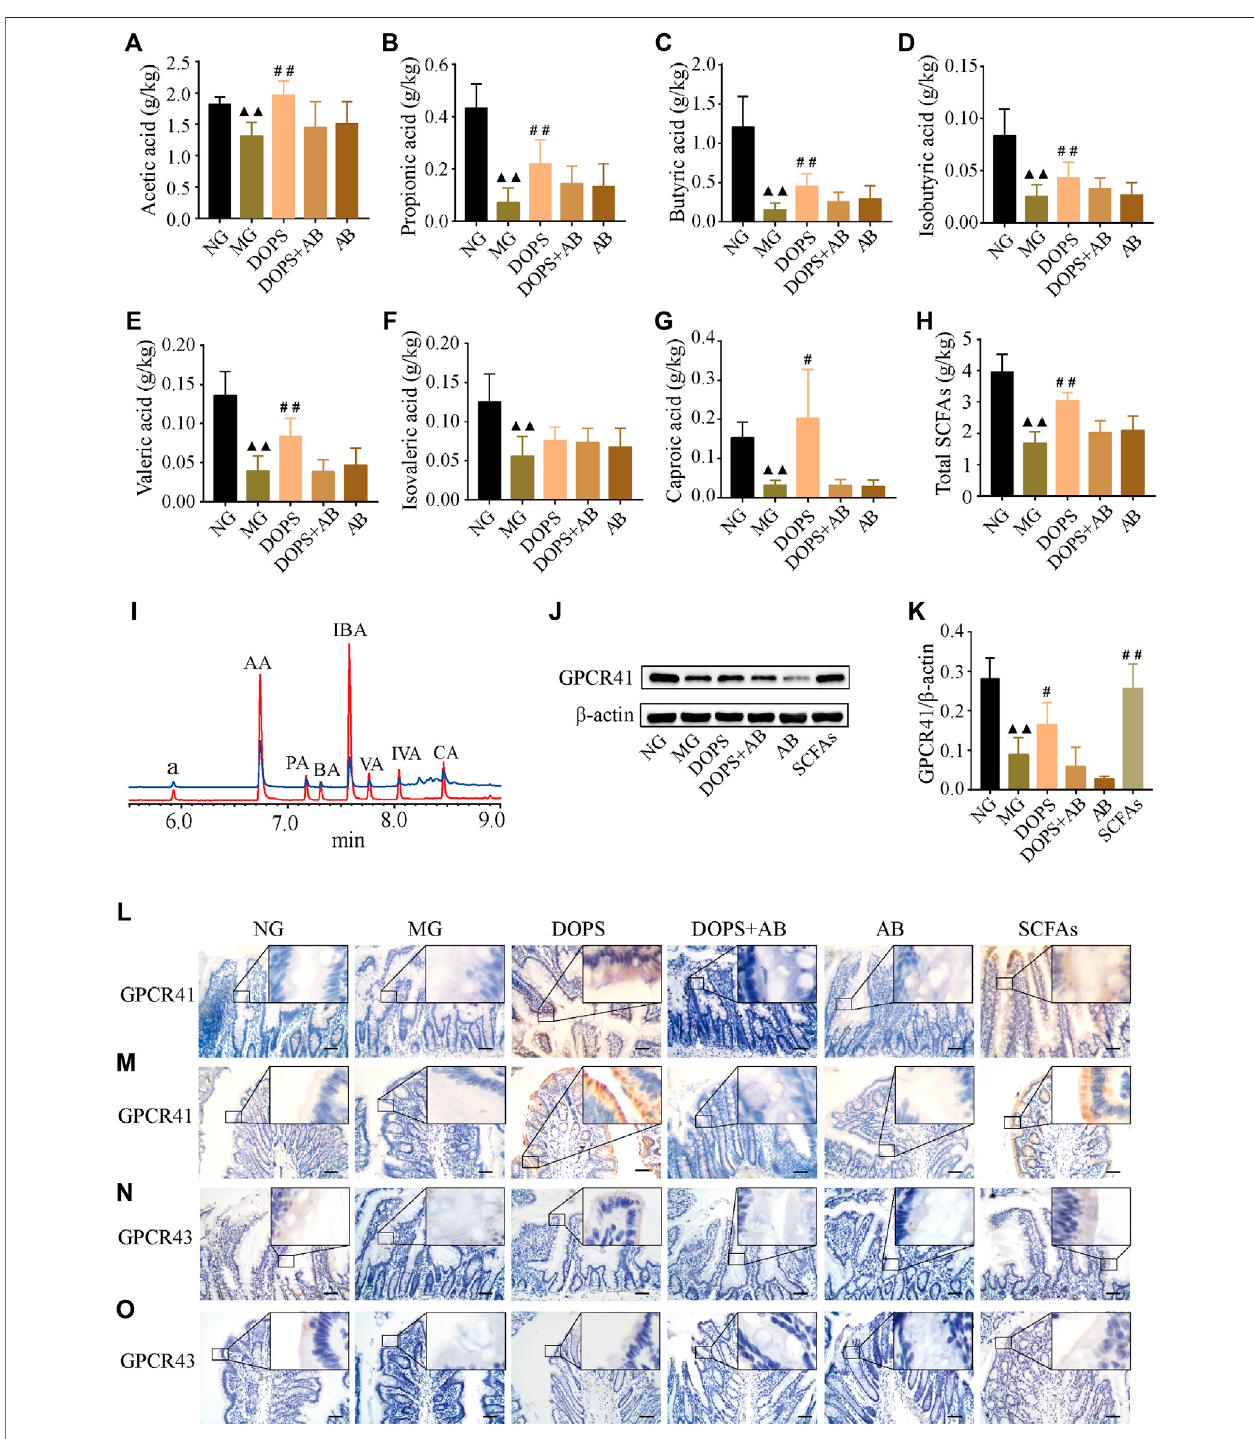
FIGURE5| EffectsonthefecalSCFAsandintestinalSCFAtransportersGPCR41/43intheMHrats. (A – H) Fecalaceticacid,propionicacid,butyricacid,isobutyric acid, valeric acid, isovaleric acid, and caproic acid and total short-chain fatty acid (SCFA) content ( n = 5). (I) GC chromatography of sample (green line) and short chain fatty acid standard (red line); a, the internal standard of cyclohexanone, AA, acetic acid; PA, propionic acid; BA: butyric acid; IBA: isobutyric acid; VA, valeric acid; IVA, isovaleric acid; CA, caproic acid. (J) Representative WB graphs of the colon G protein-coupled receptor 41 (GPCR41) and β -actin. (K) Data statistics of the expression of GPCR41 in the colon ( n = 3). (L – O) Representative graphs of GPCR41 and GPCR43 immunohistochemical staining in the ileum and colon (×400), bar = 50 μ m. NG, normal control group; MG, model control group; DOPS, Dendrobium of fi cinale polysaccharide; DOPS + AB, Dendrobium of fi cinale polysaccharide + antibiotics;AB,antibiotics;SCFAs:short-chainfattyacids.Comparedwiththenormalcontrolgroup, ▲ p < 0.05and ▲▲ p < 0.01;comparedwiththemodelcontrolgroup, # p < 0.05 and ## p < 0.01.